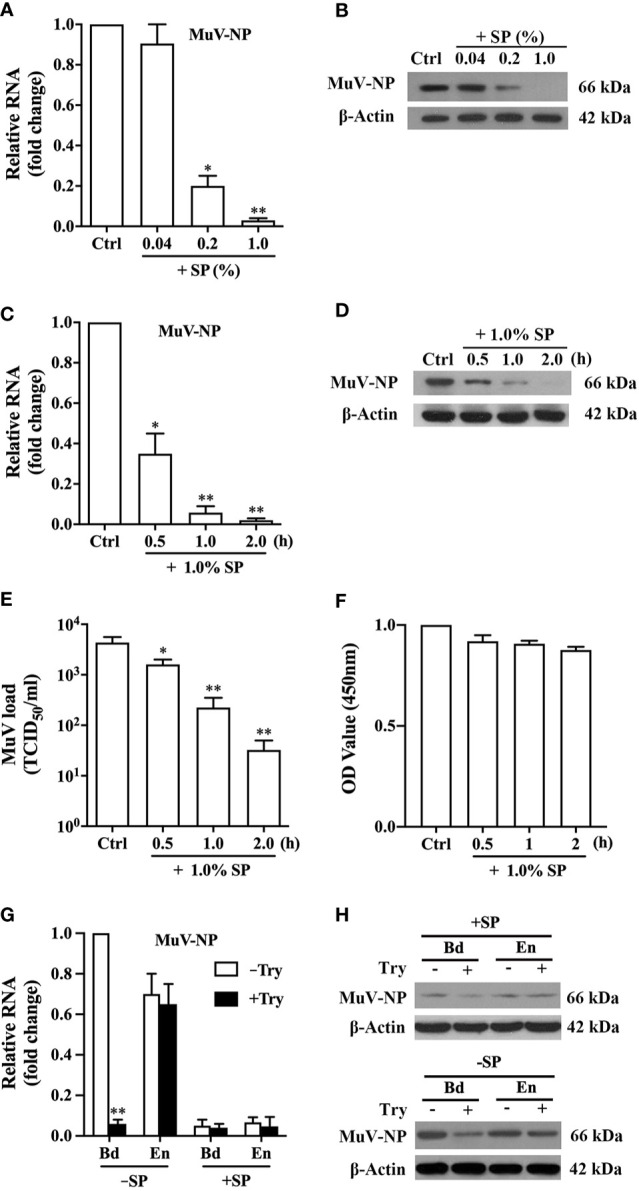
Inhibition of MuV infection by SP. (A) Dose-dependent SP inhibition of MuV infection. MuV was pre-incubated with the indicated doses of SP for 2 h, and MuV without SP treatment served as controls (Ctrl). HeLa cells were infected with MuV. Total RNA was extracted at 48 h after MuV infection, and MuV-NP RNA levels were determined using real-time qRT-PCR. (B) HeLa cells were treated as described in (A). The protein levels of MuV-NP were determined using Western blot analysis. (C, D) Time-dependent SP inhibition of MuV infection. MuV was pre-incubated with 1.0% SP for the specific durations. HeLa cells were infected with MuV for 48 h. MuV-NP RNA (C) and protein (D) levels were determined with real-time qRT-PCR and a Western blot analysis, respectively. (E) MuV loads in culture medium. MuV was treated, and HeLa cells were infected as described in (C). Culture supernatants were collected at 48 h after MuV infection, and MuV loads in culture supernatants were determined using the TCID50 assay. (F) Cell viability. HeLa cells were treated as described in (C), and the cell viability was assessed using the CCK-8 assay. (G, H) MuV binding (Bd) and entry (En). MuV was pre-incubated in the absence (−SP) or the presence (+SP) of 1.0% SP for 2 h. HeLa cells were inoculated with 50 MOI of MuV on ice for 1 h to detect MuV binding to cells. HeLa cells were inoculated with 50 MOI of MuV at 37°C for 1 h to examine MuV entry into cells. MuV bound to cells was removed by treatment with 0.25% trypsin (+Try) for 5 min. MuV-NP RNA (G) and protein (H) levels were determined using real-time qRT-PCR and Western blot analysis, respectively. Images represent at least three independent experiments. Data are presented as means ± SEM of three experiments. *P < 0.05, **P < 0.01.